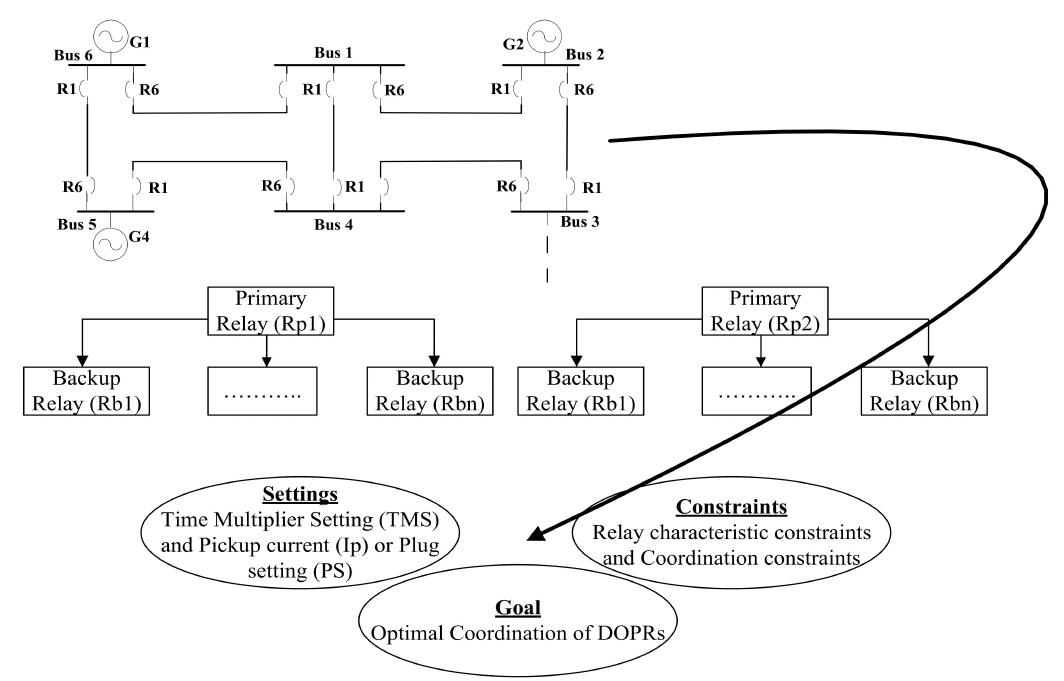
Figure 1. Schematic outline for DOPR coordination in an electrical power